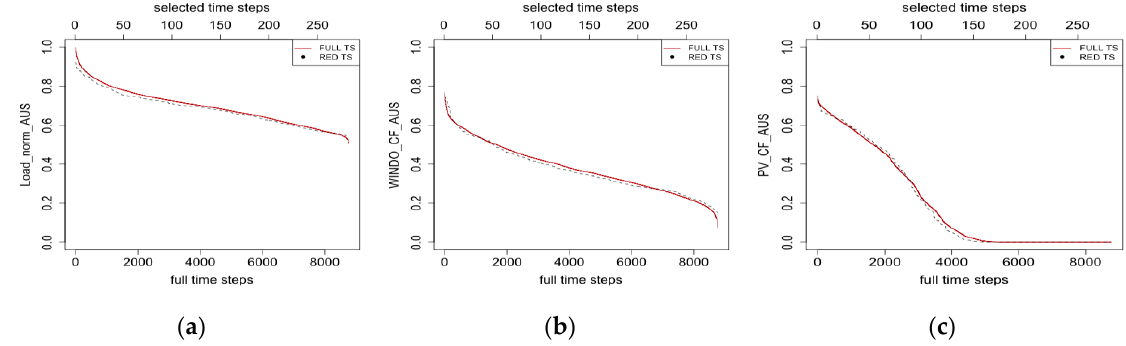
Figure A1. Duration curves based on modeled (282) time steps (black) vs. complete annual duration curves (red), taking average over all regions: ( a ) Normalized electricity load; ( b ) Wind power capacity factor; ( c ) Solar PV capacity factor.